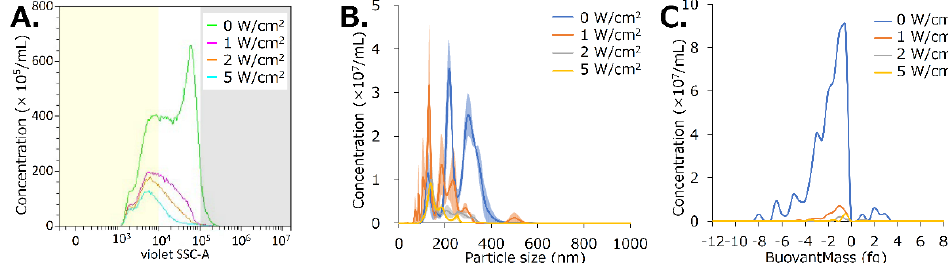
Figure 6. Characteristic changes of bubbles in solution after lyophilization by sonication. ( A ) Com- parison of bubble concentration and size distribution using FCM analysis. ( B ) Comparison of bubble concentration and particle size using NTA. ( C ) Comparison of bubble concentration and buoyant mass using RMM